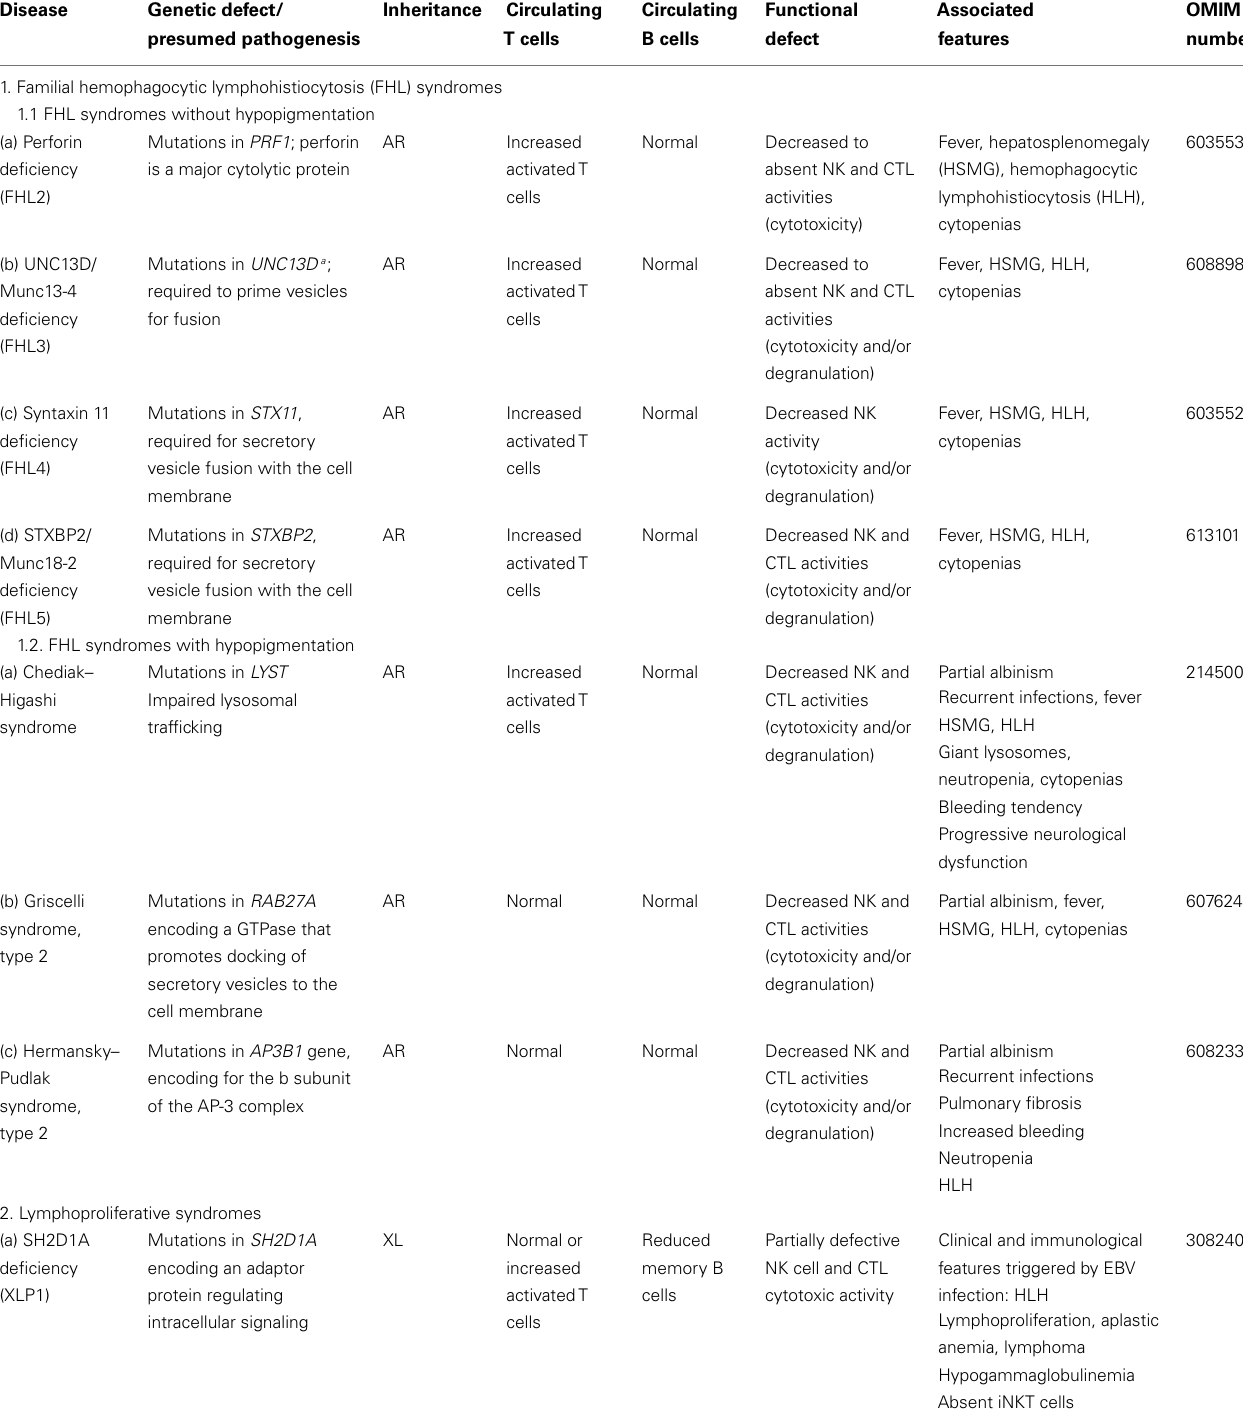
Table 4 | Diseases of immune